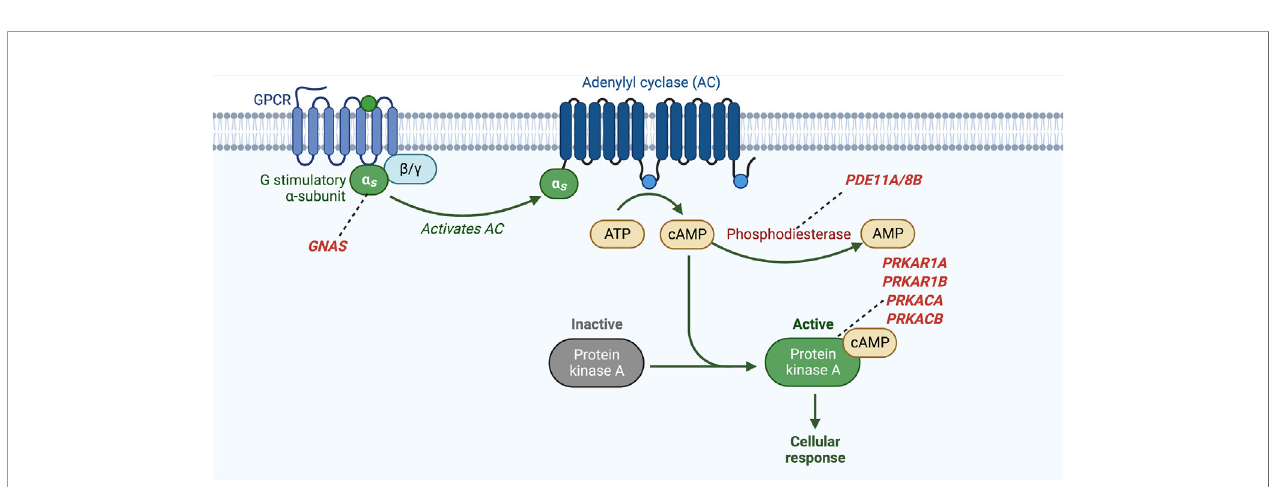
FIGURE 4 | Activation of cyclic AMP pathway through various genetic defects in adrenocortical tumors and hyperplasias. GNAS, gene coding for the stimulatory subunit a of the G-protein (Gs a ); PDE8B, phosphodiesterase 8B gene; PDE11A, phosphodiesterase 11A gene; PRKACA, protein kinase, cAMP-dependent, catalytic, alpha; PRKAR1A, protein kinase, cAMP-dependent, regulatory, type I, a